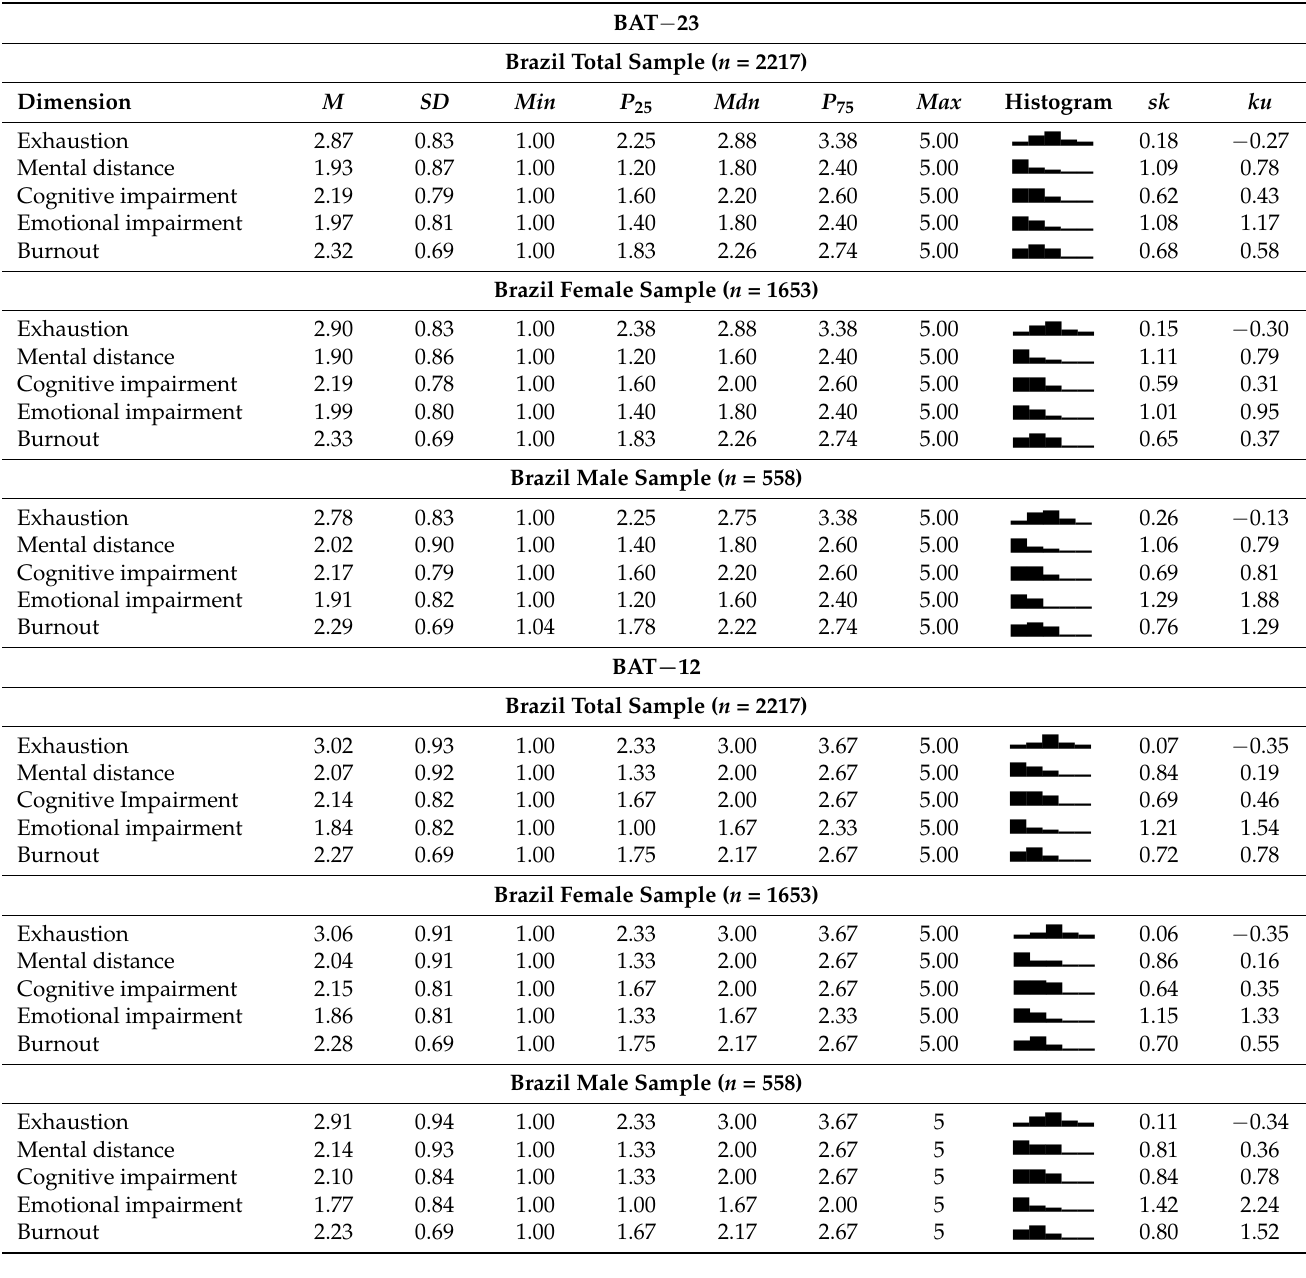
Table 6. BAT’s raw mean scores distributional properties (workers from Brazil). BAT − 23 Total Sample ( n = 2217)